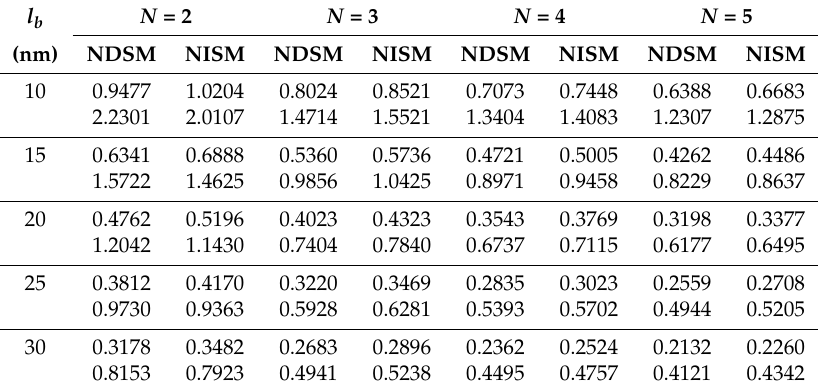
Table 2. A verification between the predicted first two longitudinal frequencies of the magnetically affected nanorod with FIFI ends according to the nonlocal-differential-surface energy-based model (NDSM) and those of the nonlocal-integral-surface energy-based model (NISM) ( ¯ k i = 3, D 0 = 4 nm, e 0 a = 1 nm, ¯ H y = ¯ H z =